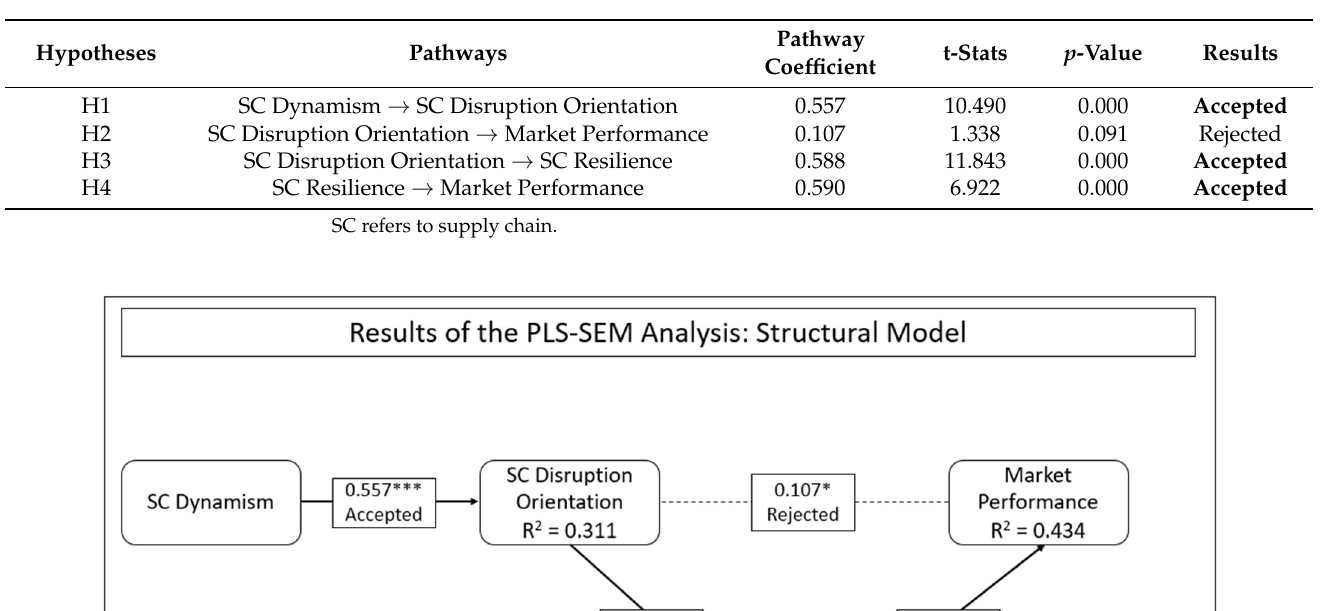
Table 5. Pathway Assessment.